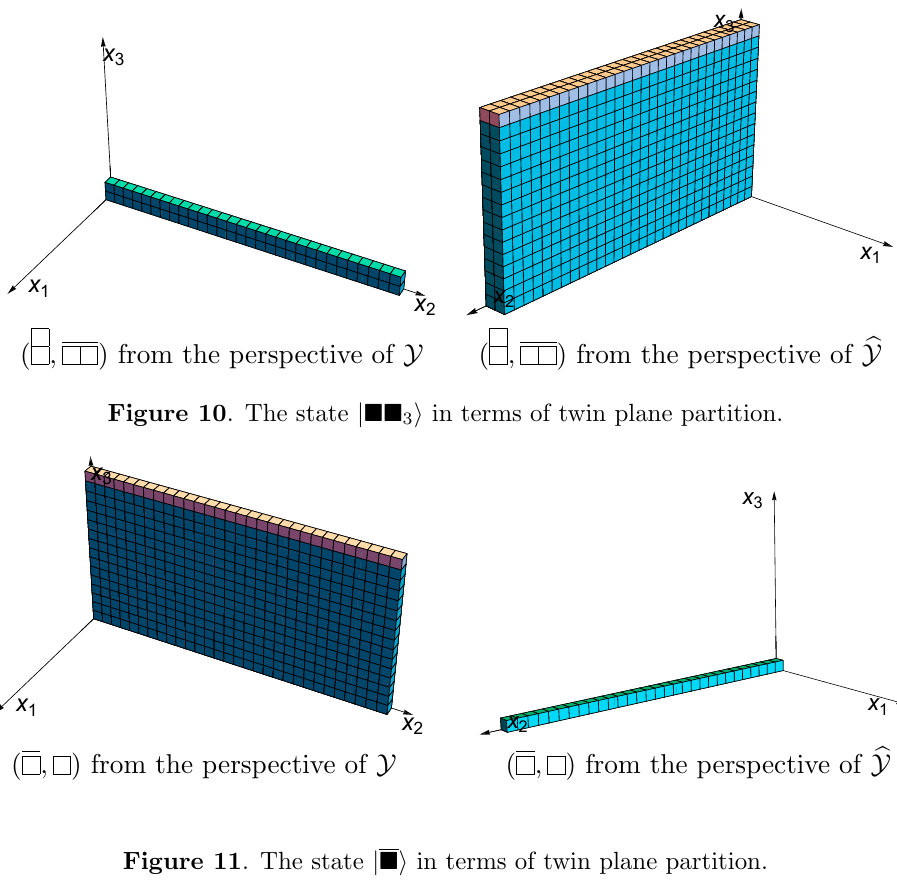
Figure 11 . The state